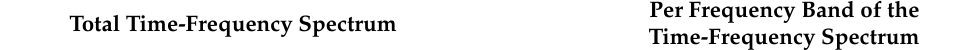
Per Frequency Band of the Time-Frequency